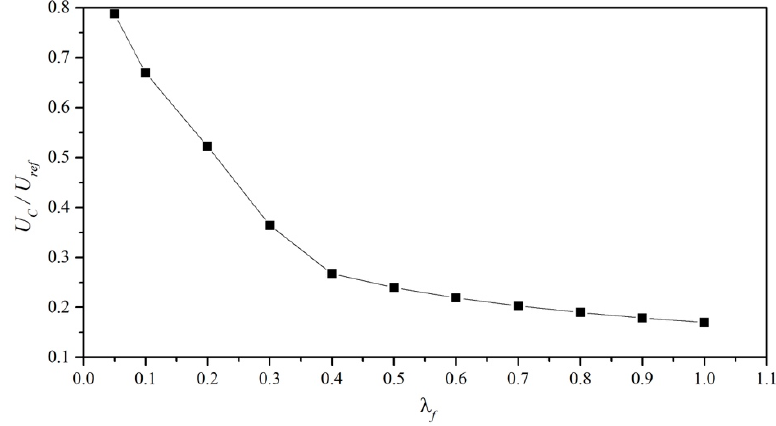
U ). Figure 7. The relationship between frontal area ratio ( λ C